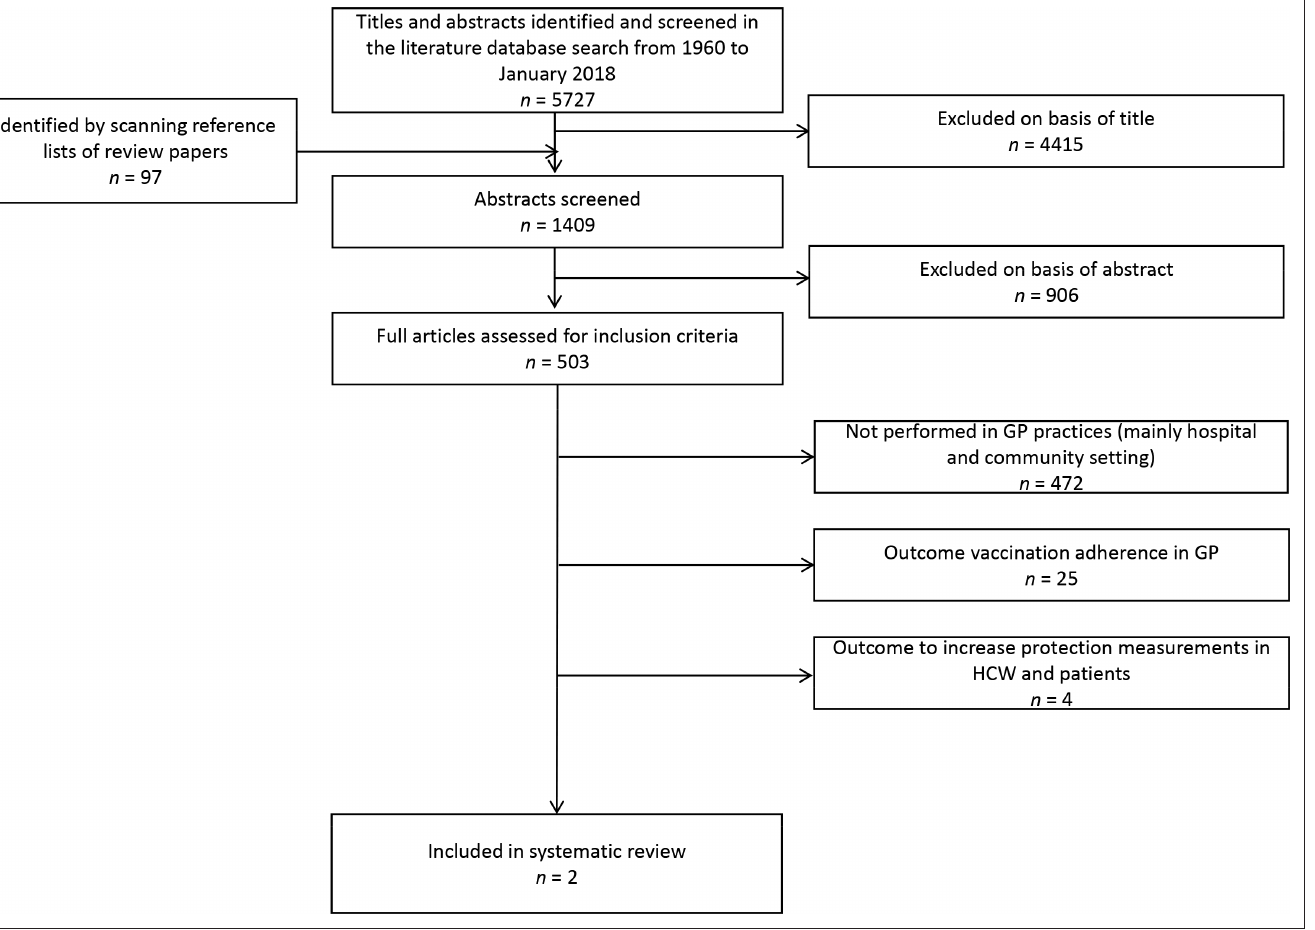
Figure 1 Flowchart of